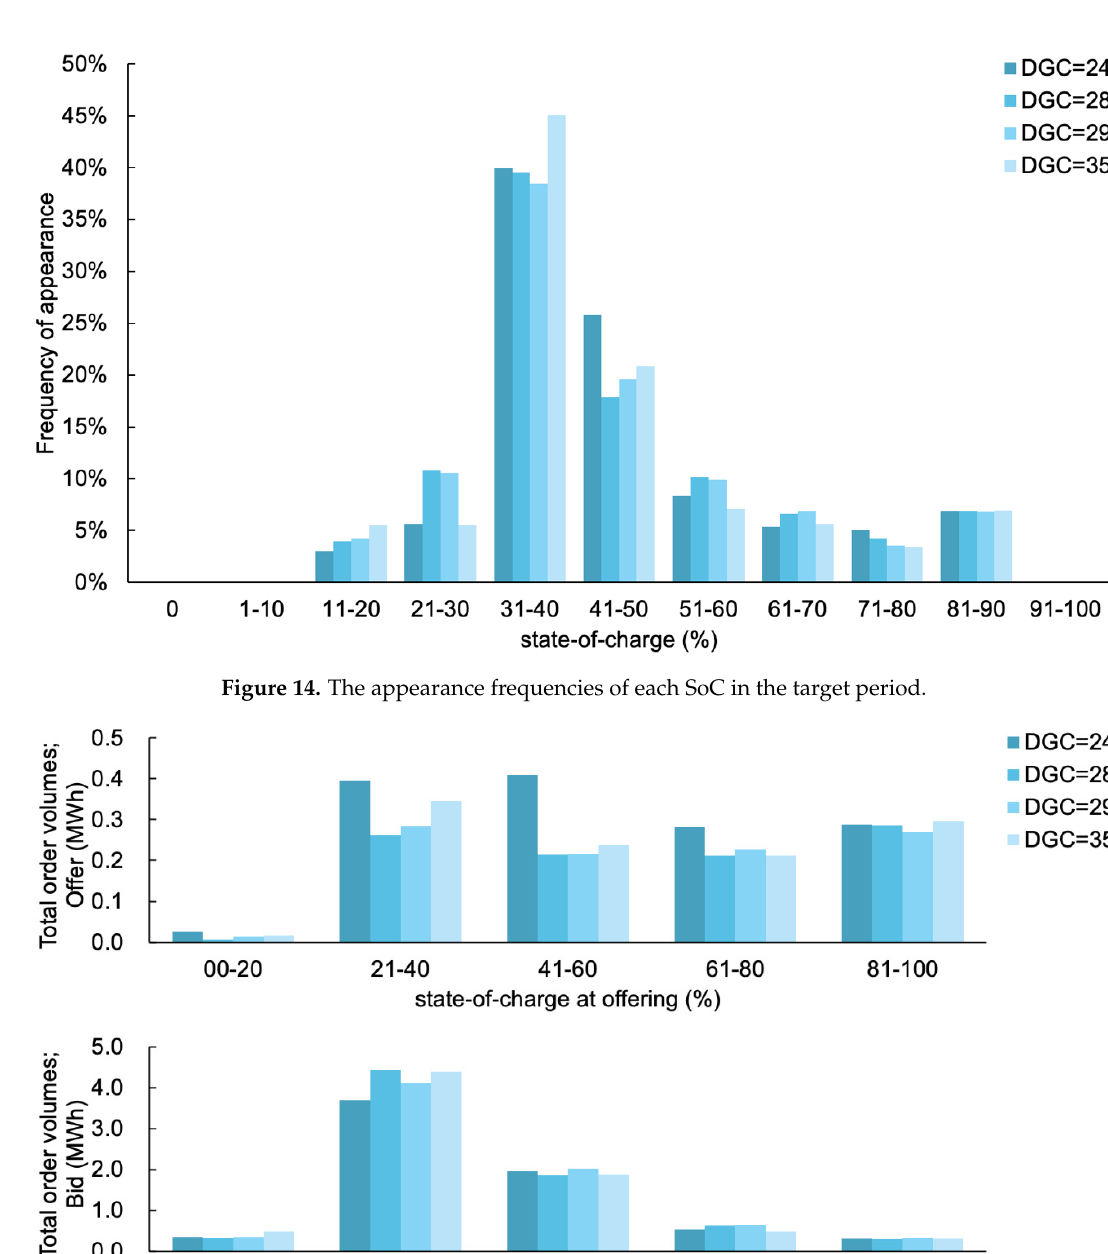
Figure 16. Mean order prices for each SoC in the target period. The total offer volumes were small when the SoC at the time of the ordering offers was low (00–20), and the total offer volumes were steady at 0.2–0.4 MWh when the SoC was higher than 20% (21–40, 41–60, 61–80, and 81–100). The total bid volumes were also